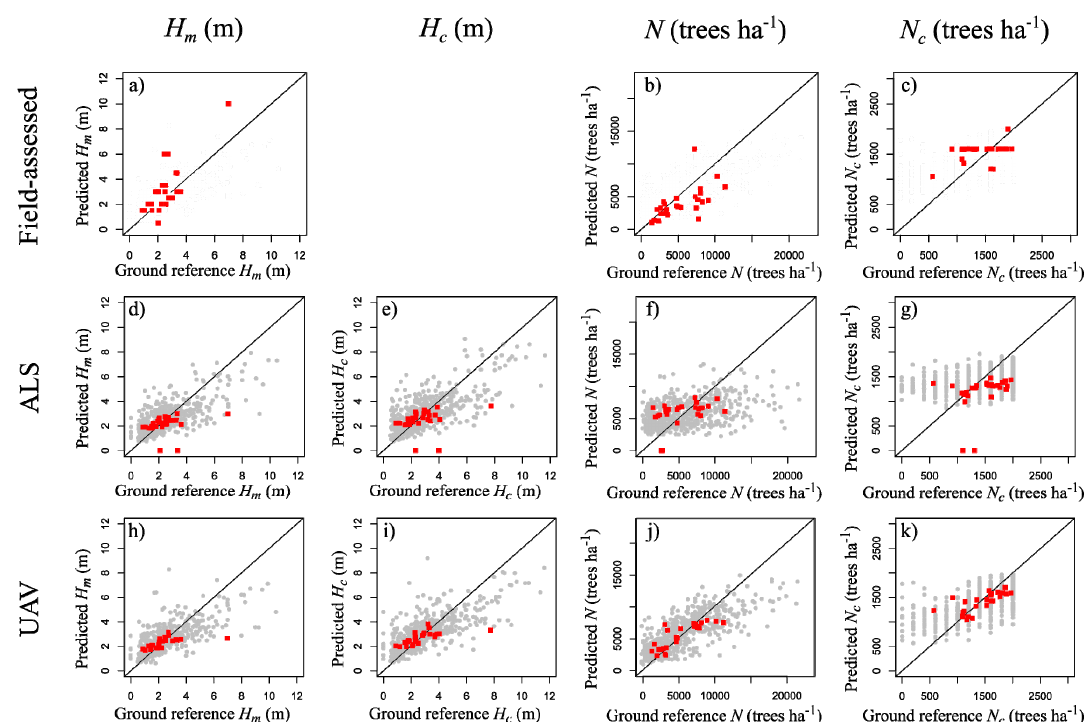
the ground reference values and the predicted values using ALS ( d – g ) and UAV data ( h–k ), respectively. Note that 𝐻 (cid:3030) was not assessed during the field interpretation, thus, no values could be plotted.